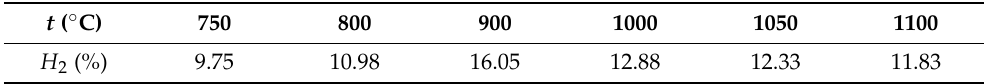
Table 1. Train data for H 2